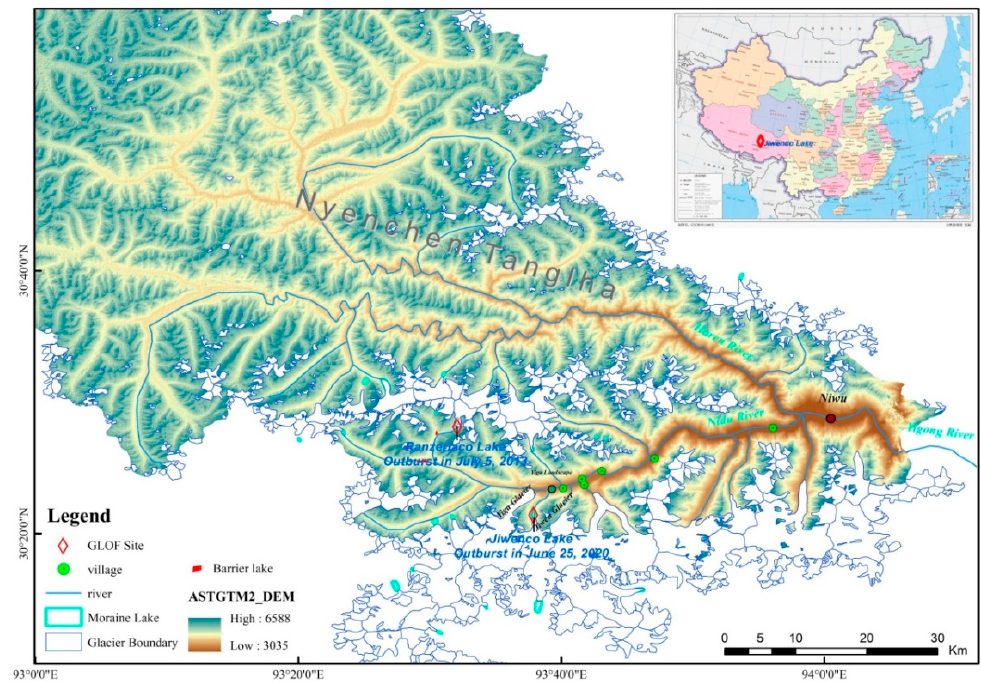
Figure 1. Location of Jiwenco GLOF site and Nidu river basin.